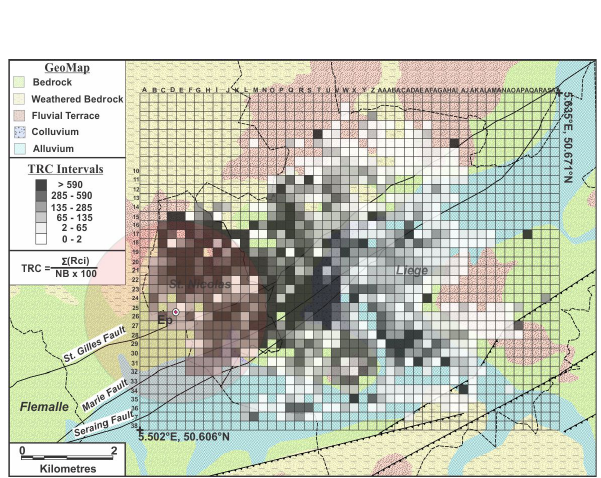
Fig. 3. Geographical distribution of the total repair cost (TRC) over Li`ege and Saint Nicolas localities according to the PSE-UL report. RC i : repair cost of individual buildings; NB: total number of build- ings per square area; Ep: